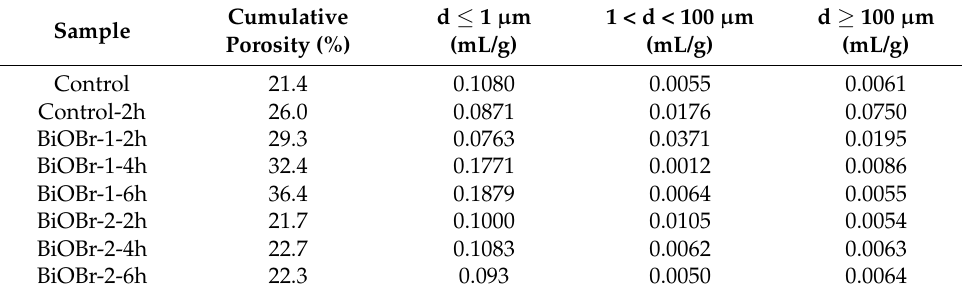
Table 2. Microstructure characteristics of